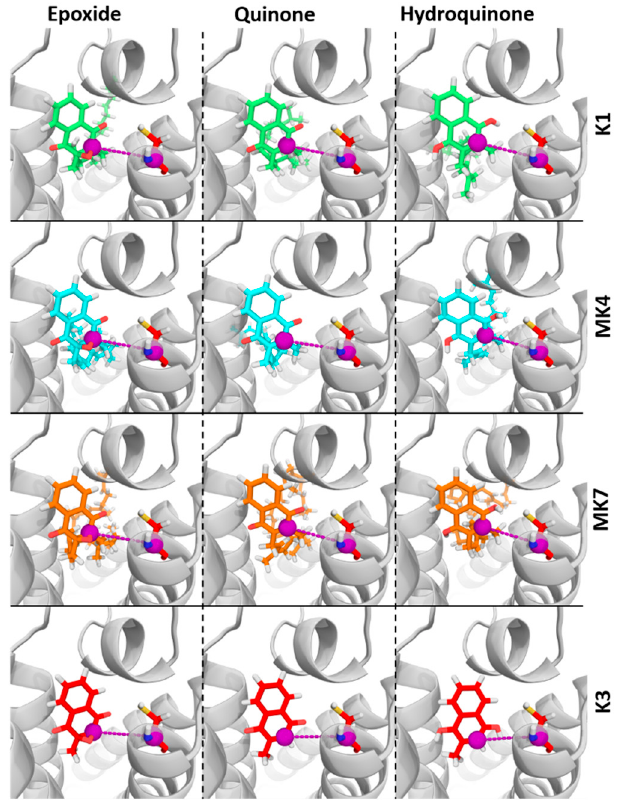
Figure A2. Molecular docking of vitamins K to vitamin K epoxide reductase (VKORC1) and distance measurement between vitamins K and C135 residue. VKORC1 3D structure is shown as a transparent grey image and the C135 residue as red sticks. Vitamin K is shown as sticks and colored in green, cyan, orange and red for K1, MK4, MK7, and K3, respectively. Oxygen, nitrogen, sulfur and hydrogen atoms are colored in red, blue, yellow, and white, respectively. The carbon-2 atom of vitamin K and the C135 α -carbon atom are shown as violet spheres, and the distance measured in molecular dynamis (MD) simulations is depicted as violet dashes.